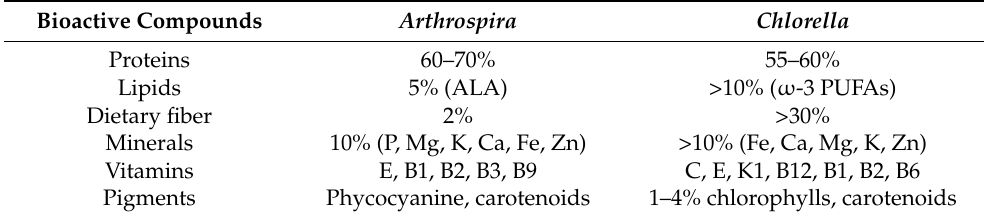
Table 1. Macronutrients and bioactive compounds present in edible microalgae (by wet weight). Bioactive